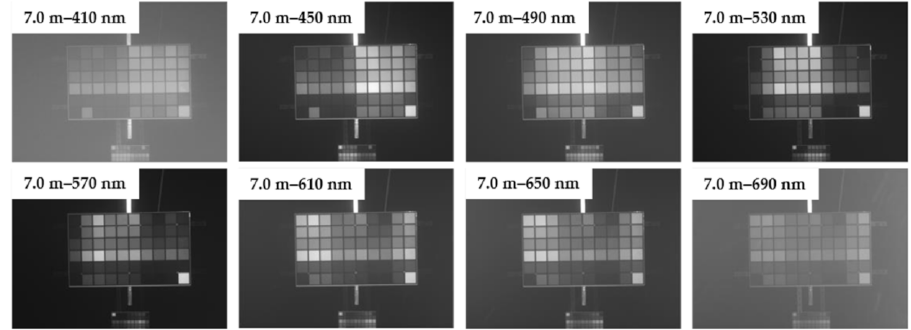
Figure 12. Single-channel spectral image of partial band color plate collected in pool test.